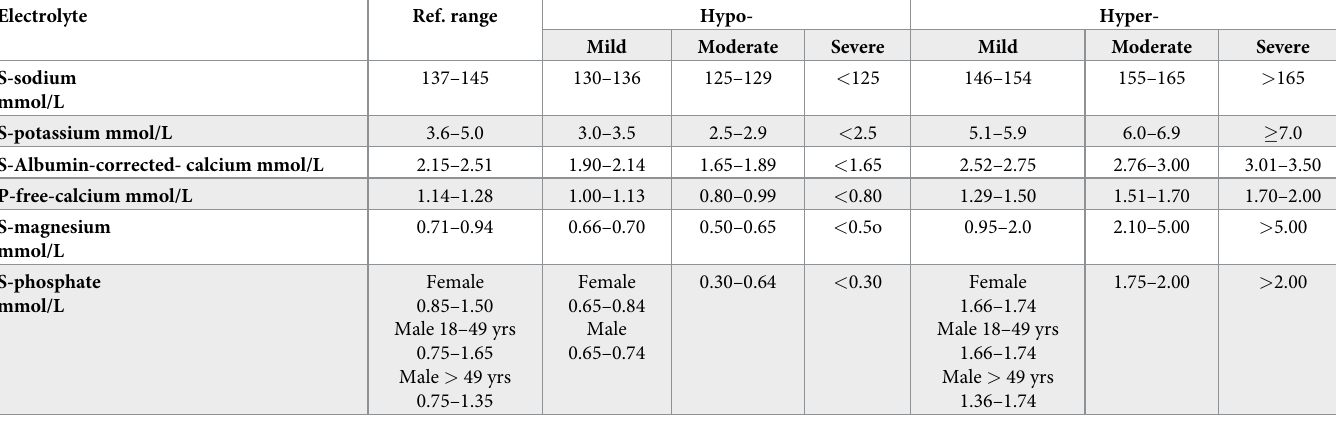
Table 1. The reference range � , and definition of electrolyte imbalances by degree of severity. All values are in conventional units with SI units in parentheses.